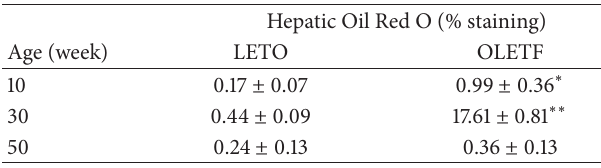
Table 4: Histological